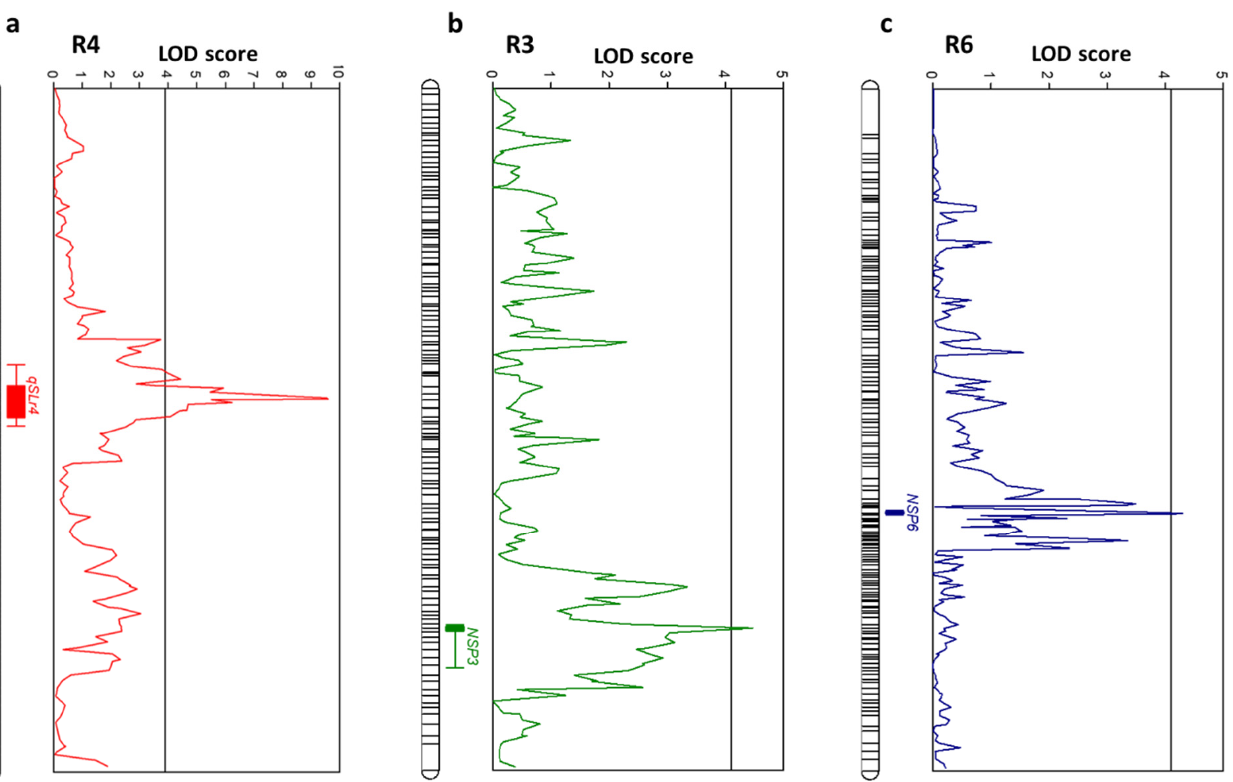
Figure 3. Logarithm of odds (LOD) score plots for linkage groups (LG) containing QTLs associated with silique length in LG-R4 ( a ) and the number of seeds per silique in LG-R3 ( b ) and LG-R6 ( c ) of radish. The horizontal lines indicate the thresholds for the LOD scores. A QTL was detected for silique length on LG-R4, with LOD thresholds of 9.59 ( qSL r4) (Figure 3a; Table 2), which explained 29.6% of the phenotypic variance (Table 2). There were eight SNPs in qSL r4, which spans from 48.781 to 55.211 cM in LG-R4 (Table S1), and negative overdominance was observed in qSL r4 for silique length. Two QTLs for the number of seeds per silique were also detected on LG-R3 and LG-R6, with LOD thresholds of 4.47 ( qNSPS r3) and 4.30 ( qNSPS r6), respectively (Figure 3b,c; Table 2). These